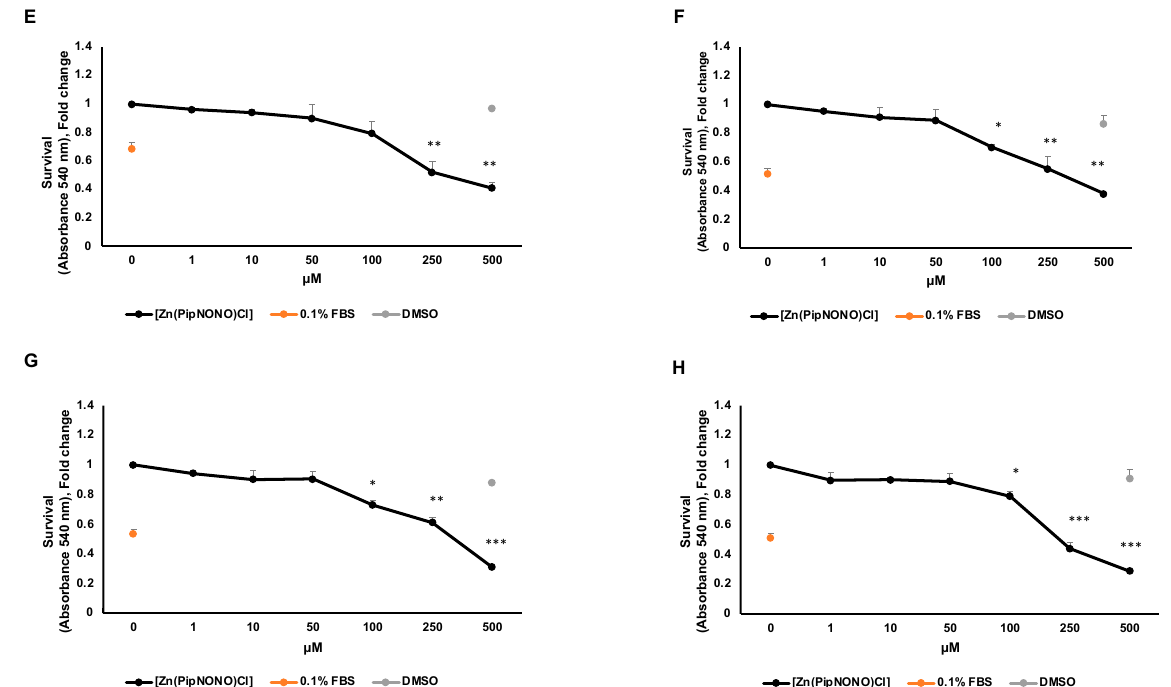
Figure 1. Effect of [Zn(PipNONO)Cl] on tumor cell survival. Dose–response curves of A549 cells treated with [Zn(PipNONO)Cl] after 24 h ( A ), 48 h ( B ), 72 h ( C ) and 96 h ( D ); and those of A375 in the same experimental conditions ( E – H ). The graphs show the cell survival response following treatment with [Zn(PipNONO)Cl], used at increasing concentrations (from 1 to 500 µ M), in the presence of medium with 10% FBS. The values of the means for each experimental point were normalized on the basal condition of medium with 10% FBS (set arbitrarily equal to 1). Medium with 0.1% FBS was used as a negative control, and DMSO used at a concentration of 0.5% was tested as a vehicle control. * p < 0.05, ** p < 0.01 and *** p < 0.001 vs. control and DMSO. 3.2. [Zn(PipNONO)Cl] Inhibited the Migration and Invasion of Tumor Cells To assess the role of [Zn(PipNONO)Cl] in tumor cell migration and invasive motility, a scratch assay was performed. [Zn(PipNONO)Cl] reduced A549 (Figure 2A) and A375 (Figure 2B) motility compared to untreated cells. The scratch-healing rate of the nonoate treatment group decreased gradually in a dose-dependent manner (Figure 2A,B).